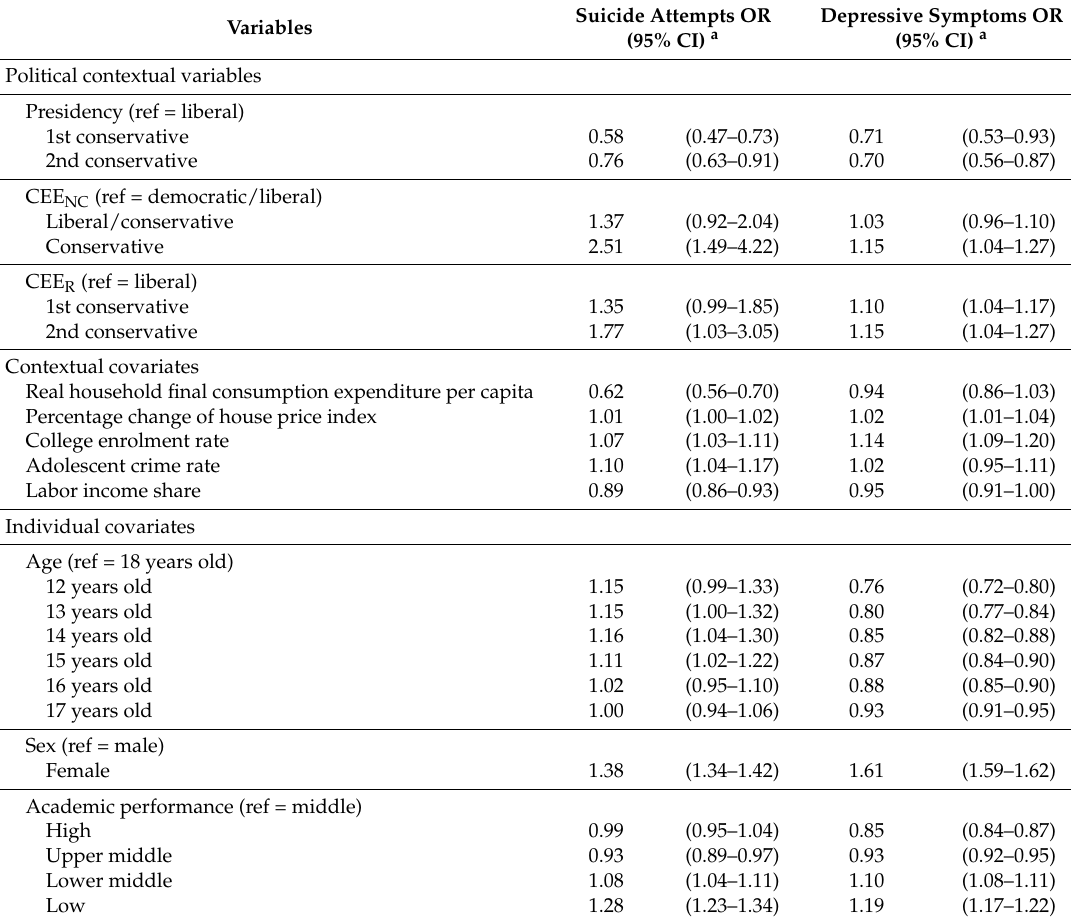
Table 2. Associations between political determinants and suicide risk among adolescents attending Korean middle- and